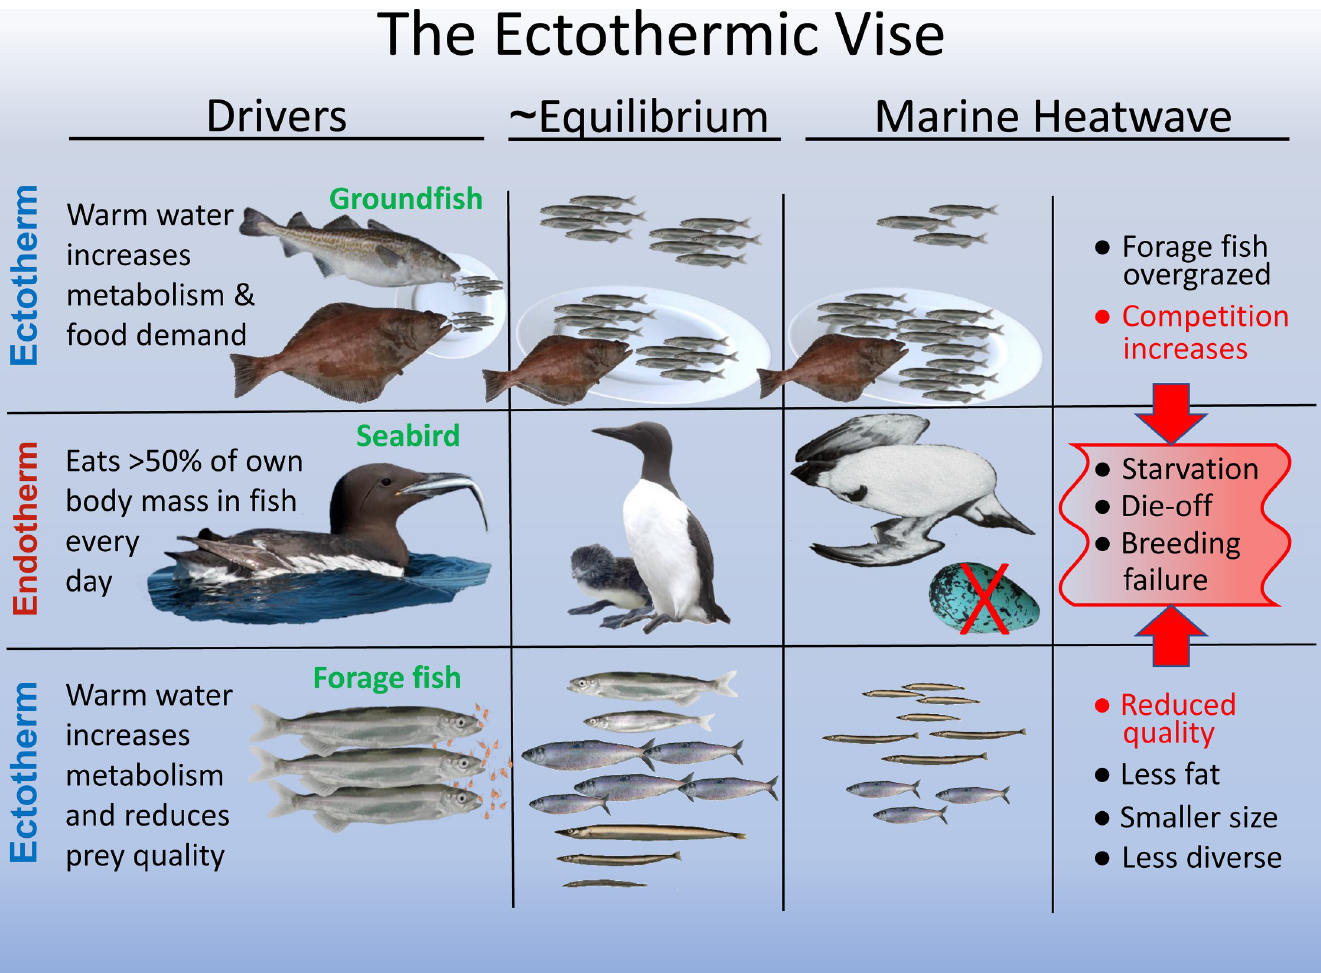
Fig 6. Illustration of the “ectothermic vise” hypothesis to explain the dramatic decline of forage fish and starvation of murres across three large marine ecosystems during the 2014–2016 marine heatwave. We propose that an unusually warm layer of water in the NE Pacific, persisting for more than 2 years, had a powerful cumulative effect on ectothermic groundfish (stimulating food intake rate) and ectothermic forage fish (reducing their quality) leading to a strong top-down and bottom up (vise-like) impact on murre survival and reproductive success.